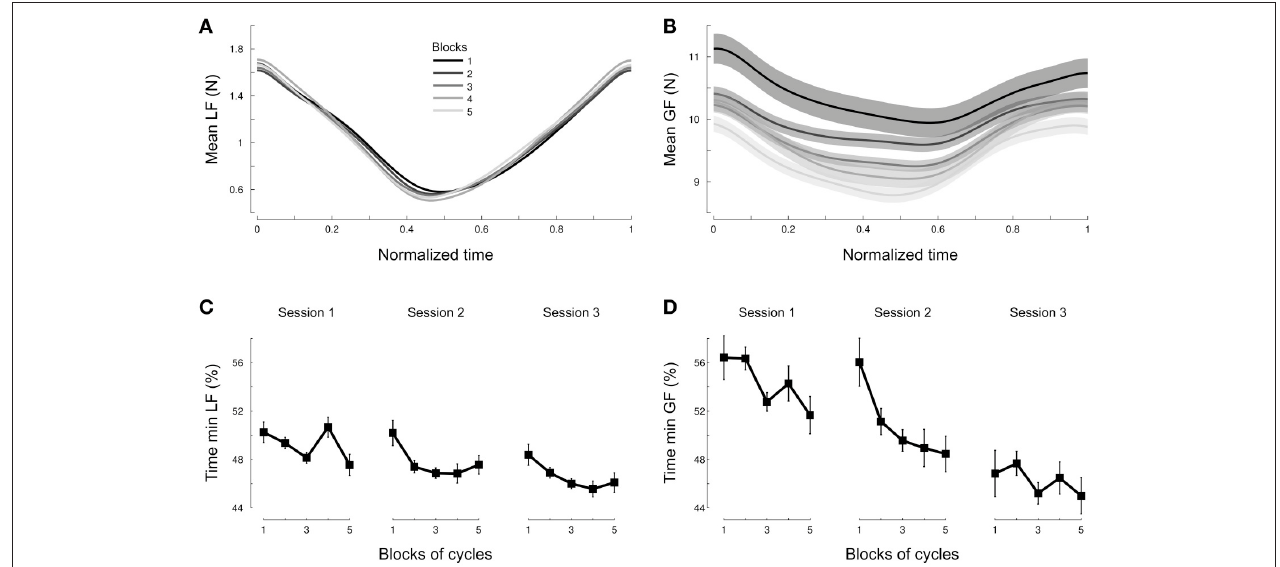
FIGURE 5 | Participants adjust grip force but not load force across cycles. Averaged load force profile during one cycle (A) and averaged grip force profile during one cycle (B) normalized across all conditions and depicted separately for each block of continuous cycles. Blocks 1 to 4 pool 3 cycles together and block 5 includes the last five cycles. The earlier blocks in the trial are depicted in dark gray and late blocks are shown in light gray [see legend in (A) ]. The occurrence of minimum load force (C) and grip force (D) within a cycle is plotted as a function of block. The three sessions are shown separately. Time is normalized by cycle length in all